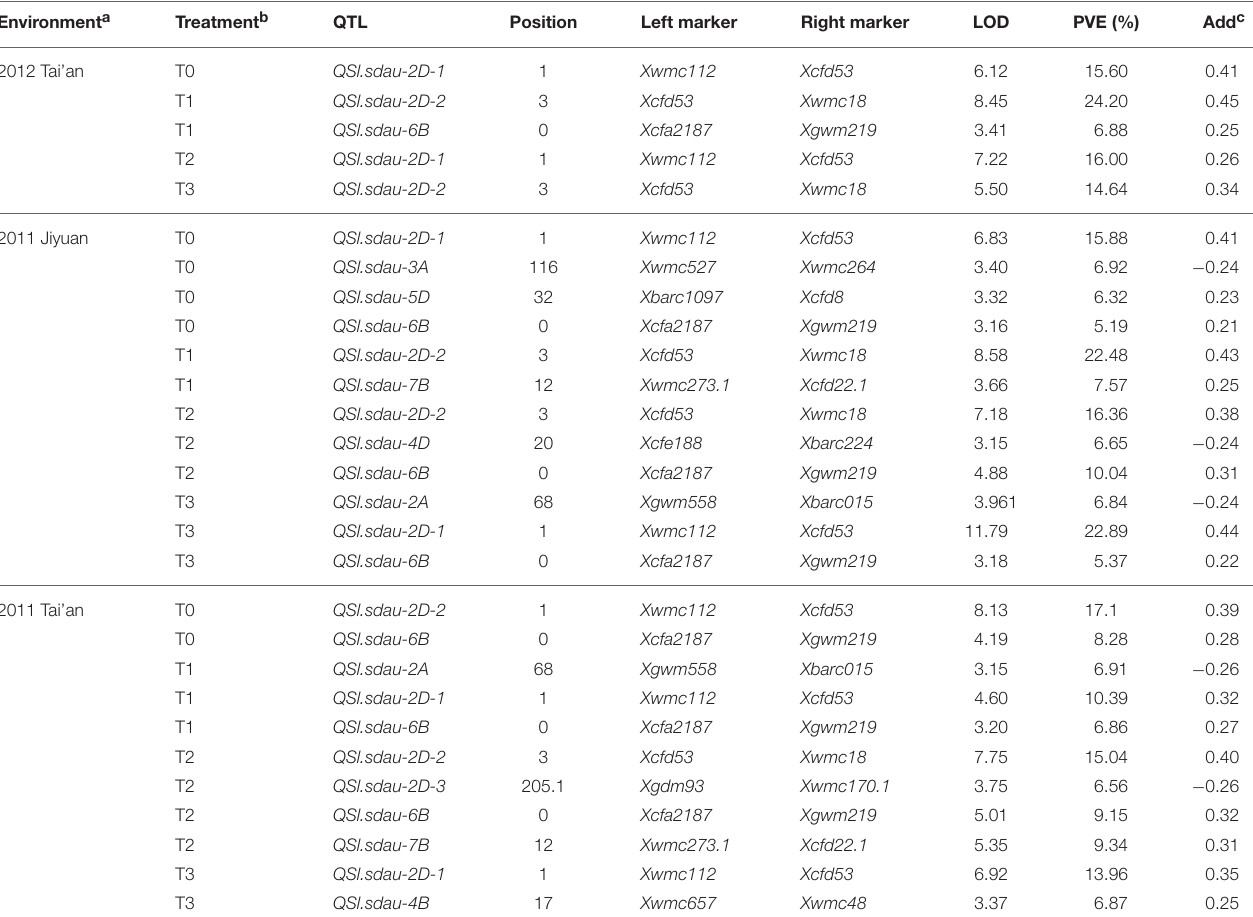
TABLE 4 | Additive QTLs for spike length identified under different nitrogen supply dates in different years. Environment